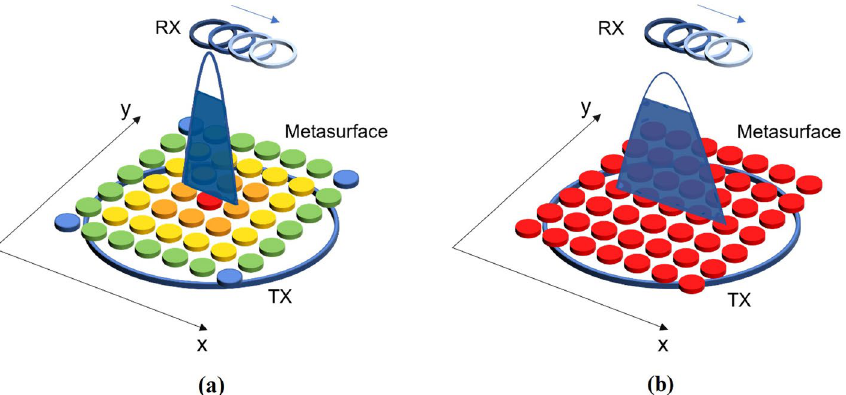
Figure 1. Phenomenology of the WPT systems arrangements presented in this manuscript: ( a ) classical metasurface configuration, suffering from strong truncation effects; ( b ) magnetic metasurface configuration